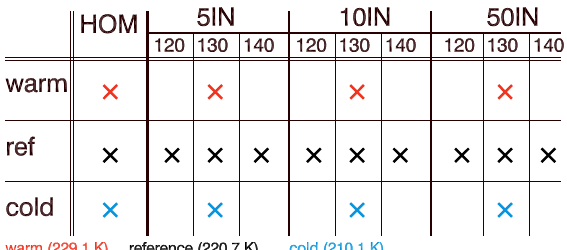
Figure 2. Summary of all 18 LES simulations. Each symbol repre- sents one simulation. The temperature profile is shown in the ver- tical, whereas the temperature indicated at the bottom refers to the temperature inside the ISSR. The whole profiles can also be found in Joos et al. (2009). The horizontal shows how many IN are in- cluded in the simulation from 0 in HOM to 50L − 1 in the 50 IN simulation. Furthermore, the critical relative humidity at which the IN are assumed to initiate heterogeneous freezing is shown, namely at 120, 130 or